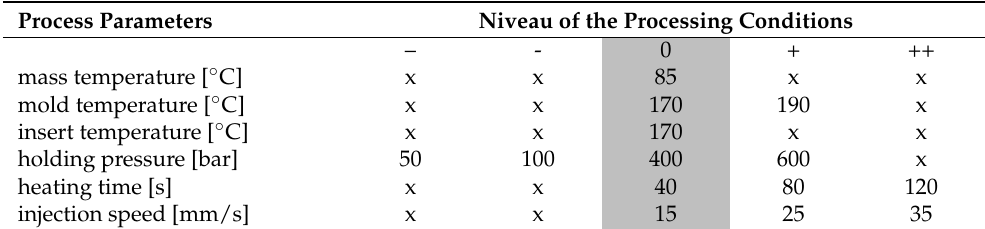
Table 1. Processing parameters of injection molding to fabricate the single slot sample